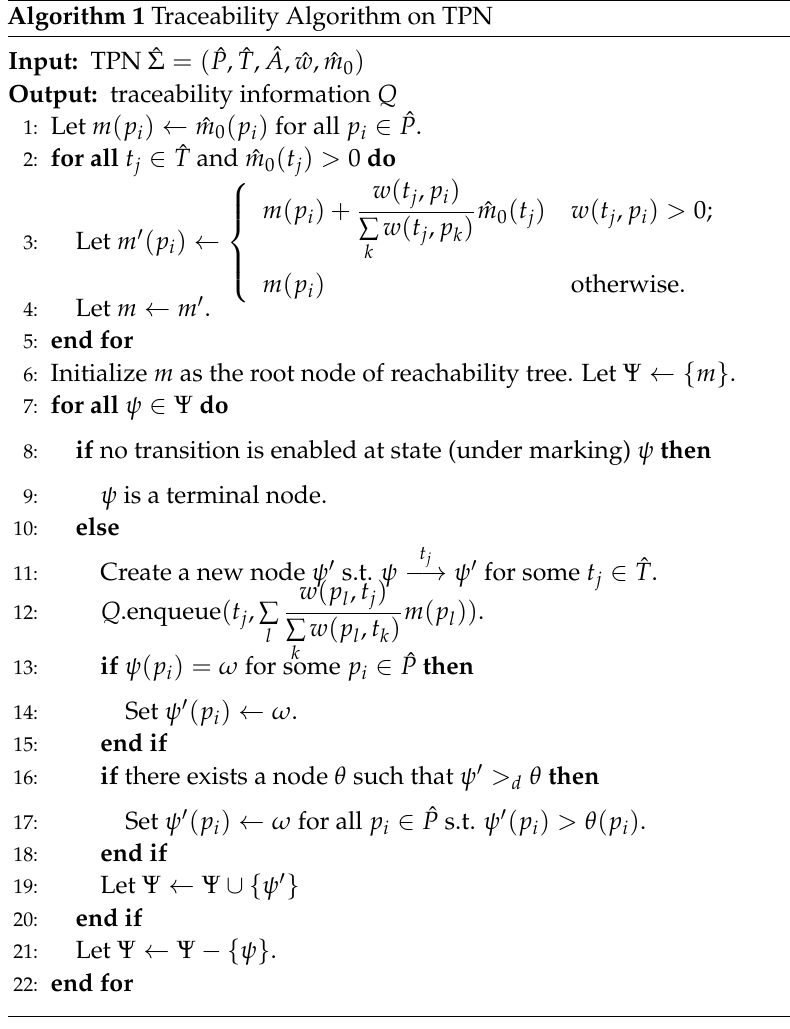
Algorithm 1 Traceability Algorithm on